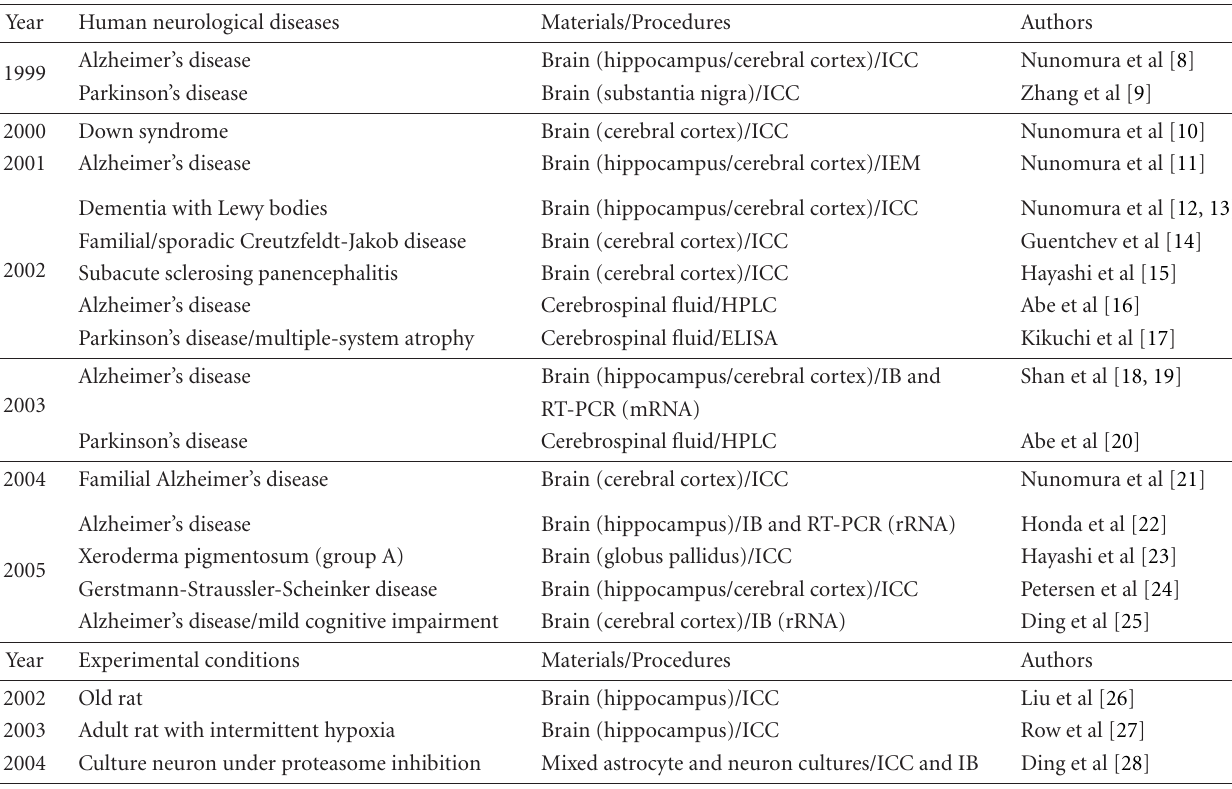
Table 1: Summary of studies on RNA oxidation in the central nervous system. (ELISA: enzyme-linked immunosorbent assay; HPLC: high- performance liquid chromatography; IB: immunoblot; ICC: immunocytochemistry; IEM: immunoelectronmicroscopy; RT-PCR: reverse transcription and polymerase chain